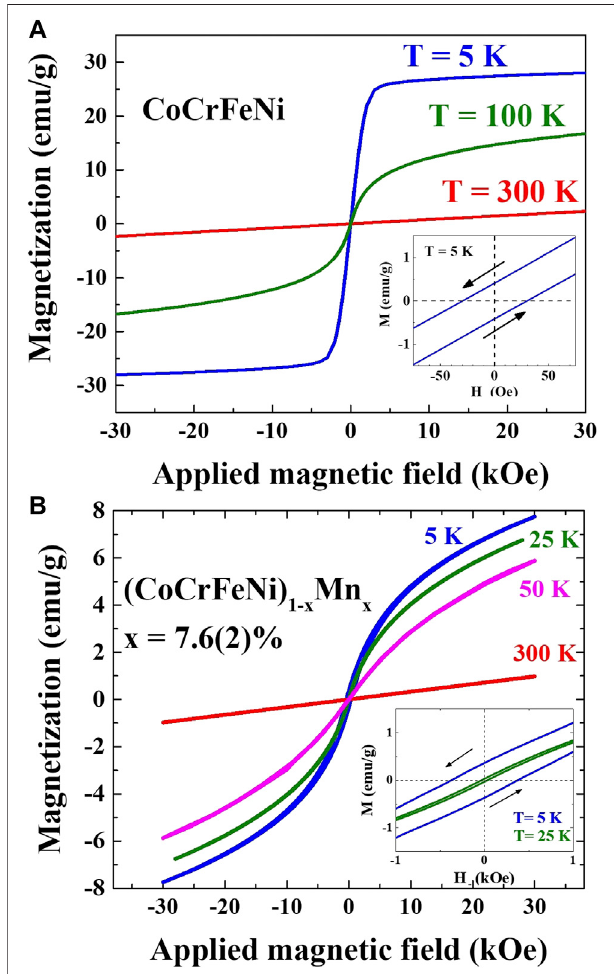
FIGURE 2 | Thermal variation of the zero- fi eld-cooled (A) magnetization M of the Mn-free CoCrFeNi HEA measured during warming with H a = 1 kOe and (B) magnetic susceptibility of the (CoCrFeNi) 1 − x Mn x HEA at x = 7.6% measured during warming under several different applied magnetic fi elds. The insets show the transition temperatures determined from the derivative of magnetic susceptibility with respect to temperature.